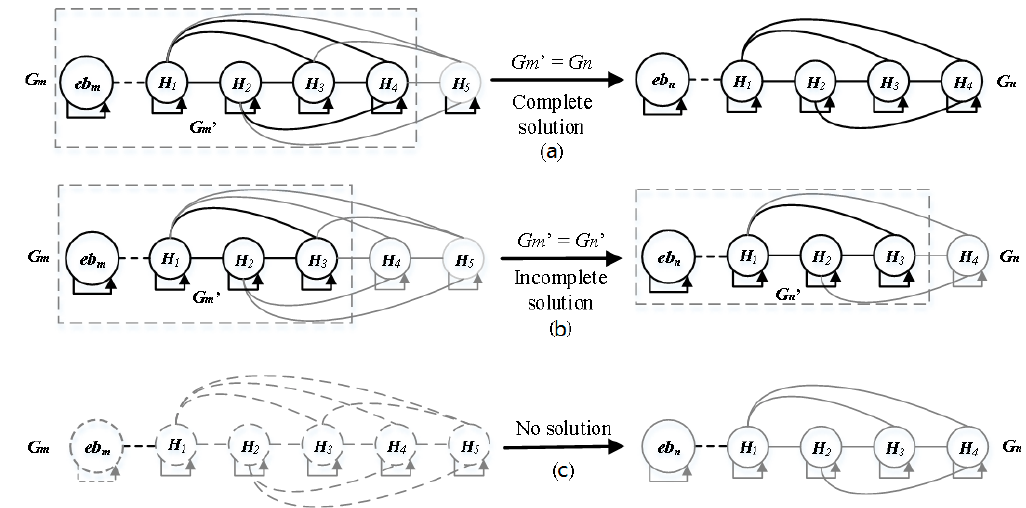
Figure 10. ( a ) Complete solution; ( b ) incomplete solution; ( c ) no solution.